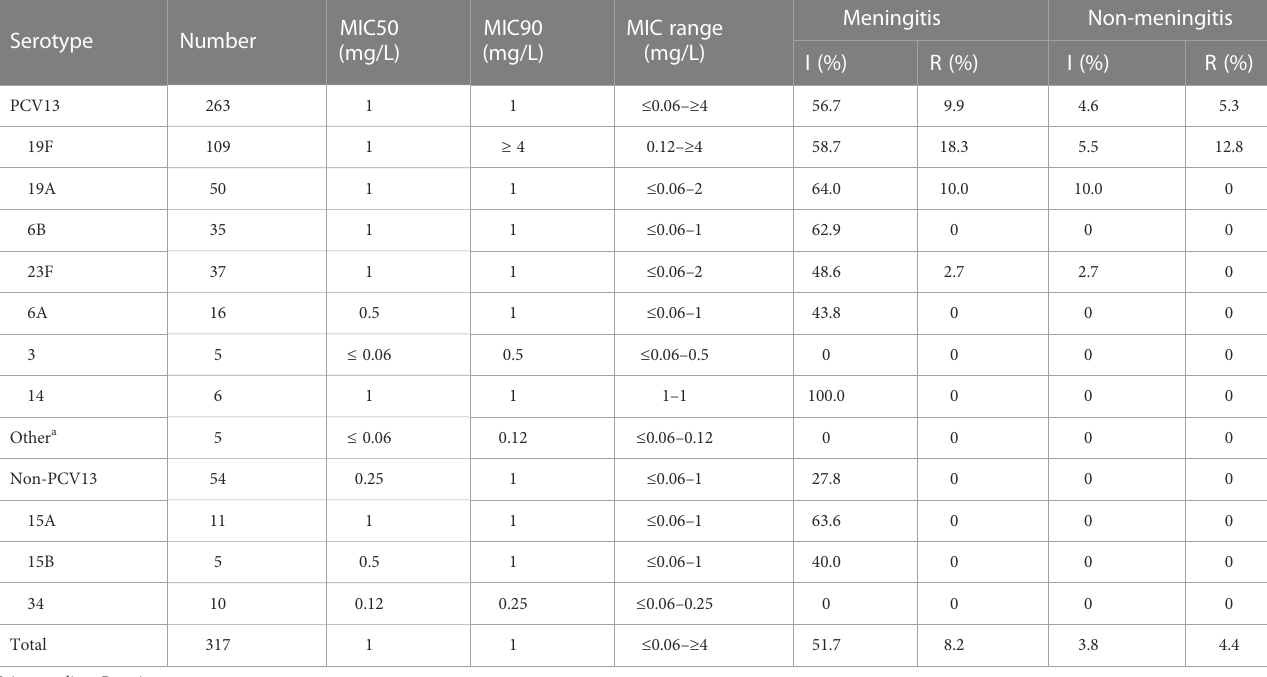
TABLE 4 Comparison of the susceptibility of S. pneumoniae to ceftriaxone between different